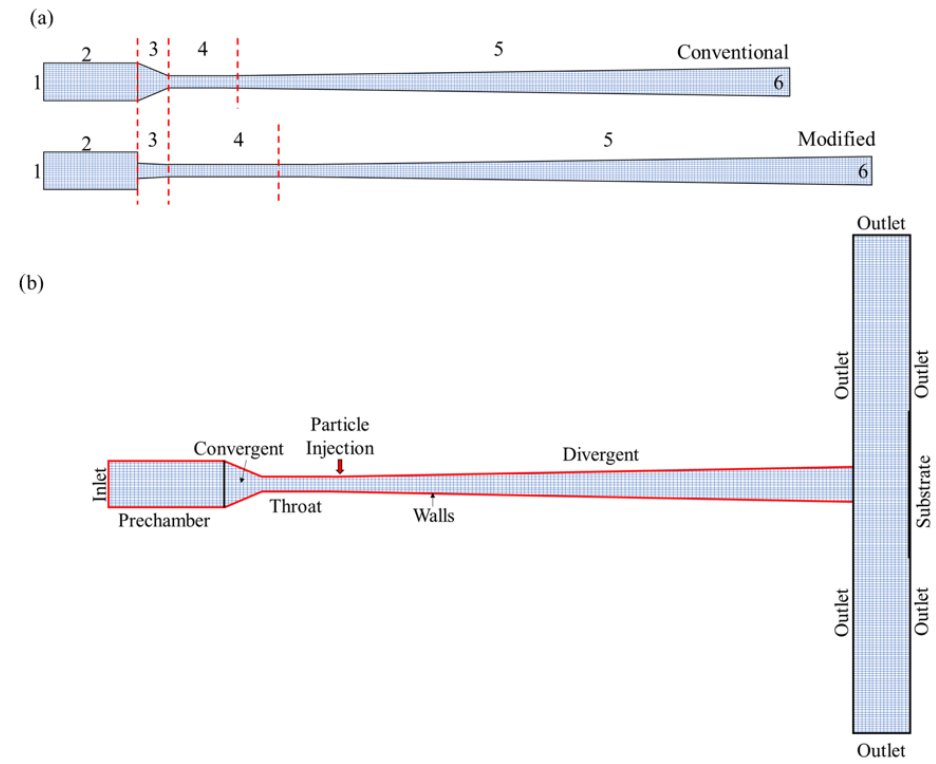
Figure 1. ( a ) Scale drawing of conventional and modified nozzle geometry. Nozzle sections are numbered as follows: (1) inlet, (2) prechamber, (3) converging, (4) throat, (5) diverging, and (6) outlet; ( b ) Sections and boundary conditions used in the conventional nozzle.